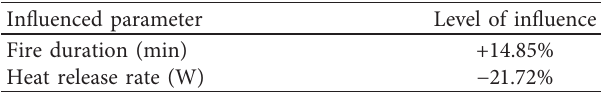
Figure 17: Angle of the shift of the effect of confining on the heat release rate of the fire source. Table 7: Percentage and direction of influence of confining on the fire duration and heat release rate of the source.